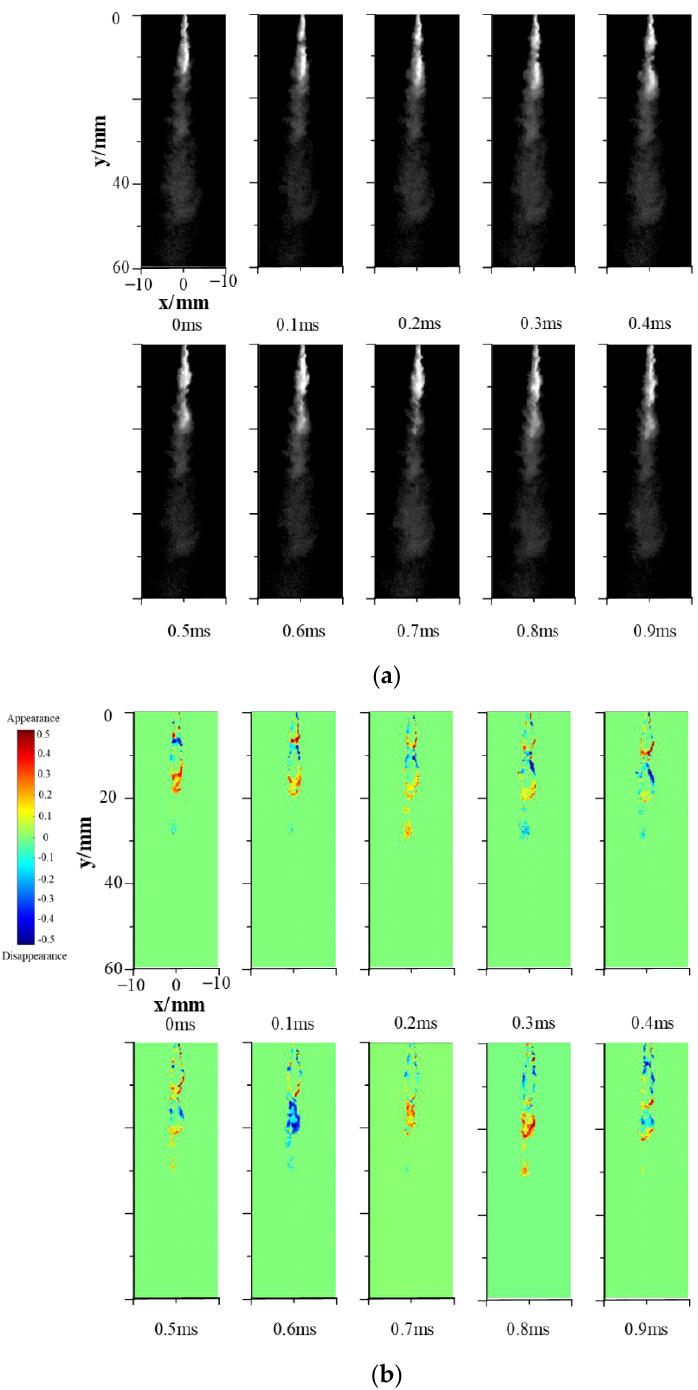
Figure 5. Dynamic change in the cavitation cloud in a single period under an inlet pressure of 15 MPa: ( a ) high-speed photography image of the cavitation cloud; ( b ) FDM diagram.